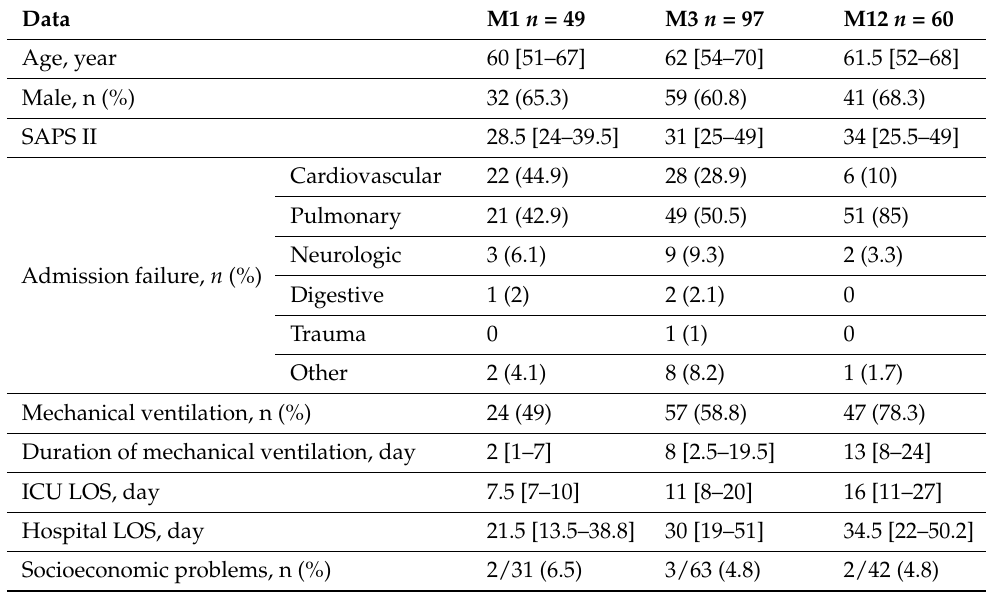
Table 1. Patients’ characteristics at the three timepoints.